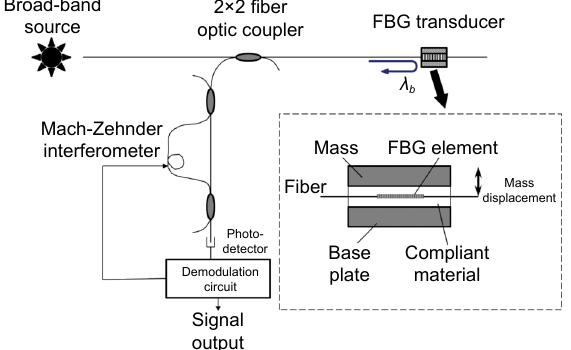
Fig. 12 | Simplified model of an FBG based accelerometer. Fig- ure reproduced with permission from ref. 47 ,